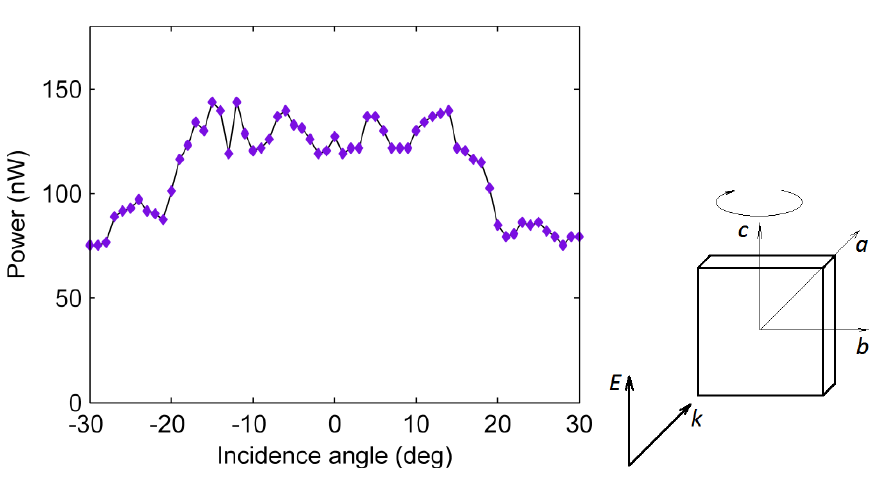
Figure 7. An example of angular dependence of DUV generated in NPC